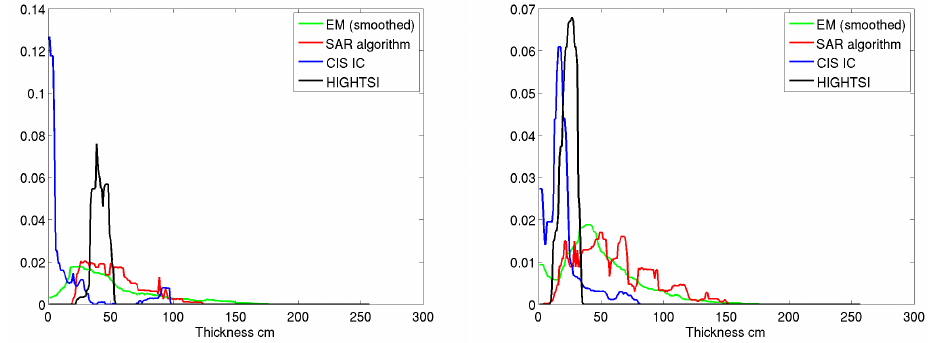
Fig. 15. The ice SAR algorithm thickness compared to HIGHTSI ice thickness, mean ice thickness derived from digitized CIS ice charts, and EM ice thickness measurements along the EM measurement lines for the two test seasons (2002–2003 in left panel, 2008–2009 in right panel). The x-axis value is the number of the EM measurements resampled to the SAR mosaic resolution of 500m; in the figure all the EM flight lines for each year have been concatenated in temporal order.